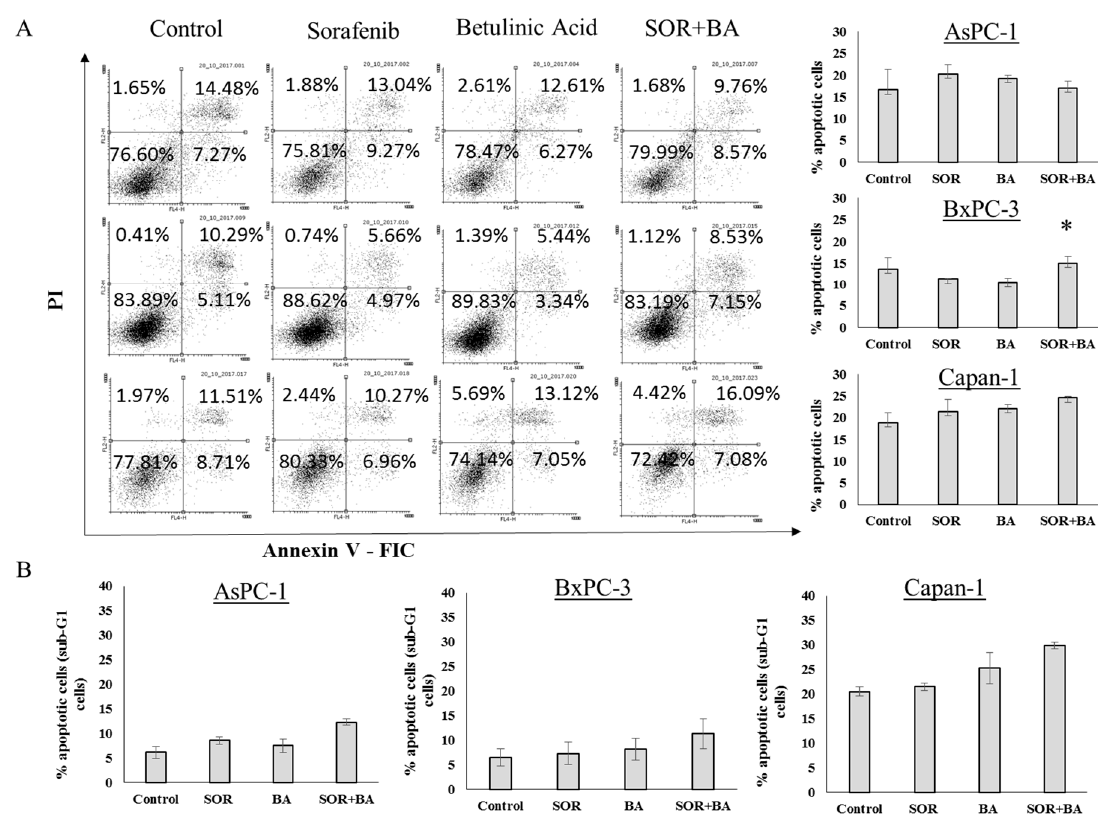
Figure 2. Cytotoxicity effect of combination treatment with SOR and BA on PDAC cells. ( A ) Representative FACS dot plots showing the effect of combination treatment with sorafenib (AsPC-1 and Capan-1: 5 µ M, BxPC-3: 3 µ M) and betulinic acid (6 µ M) on phosphatidylserine exposure and plasma membrane integrity after 72 h of incubation with pancreatic cancer cells, as determined by annexin V-FIC/PI staining. ( B ) Apoptosis-associated DNA fragmentation of AsPC-1, BxPC-3, and Capan-1 cells after treatments